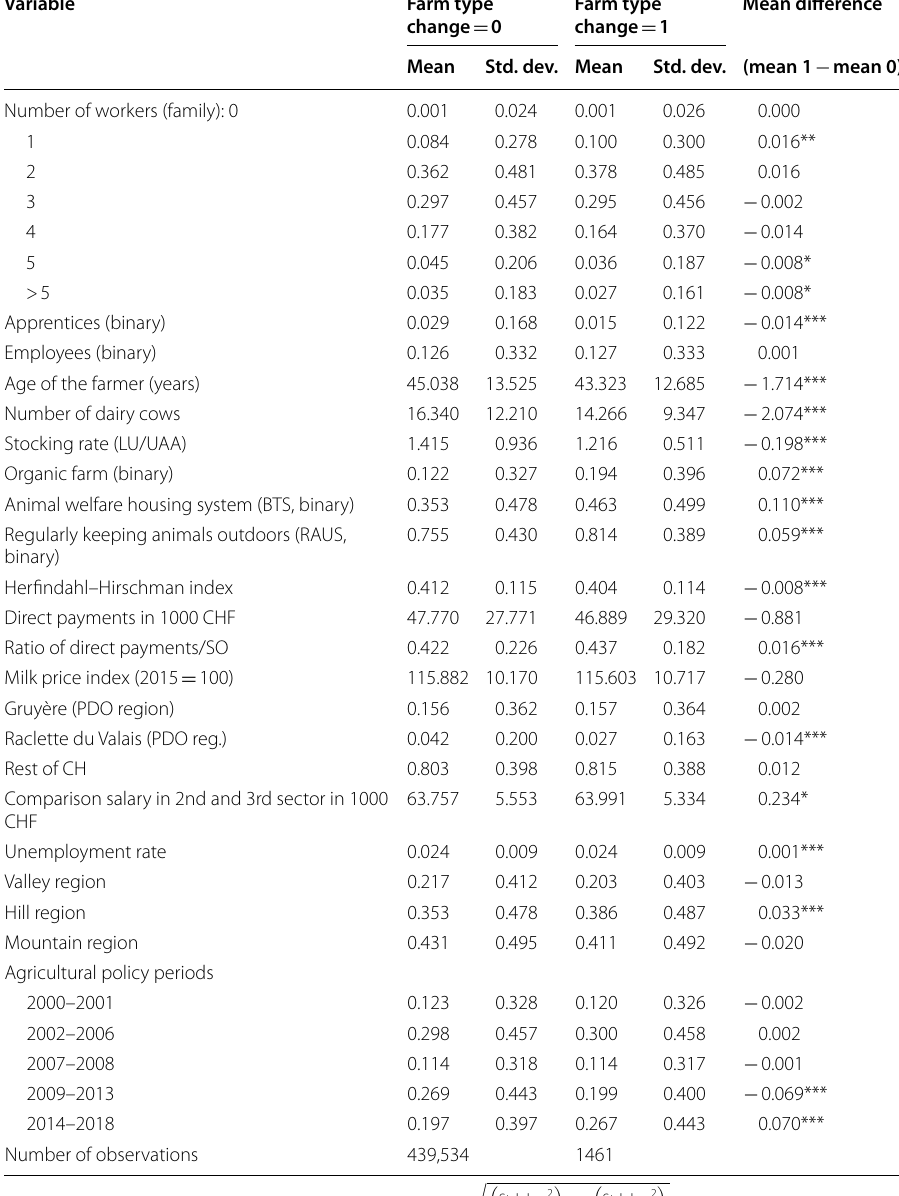
Table 6 Summary statistics of farms who change to specialised suckler cow farm type and those who do not. Source : Authors’ calculations based on AGIS 2000–2017, milk price data from the FSO and unemployment data from the